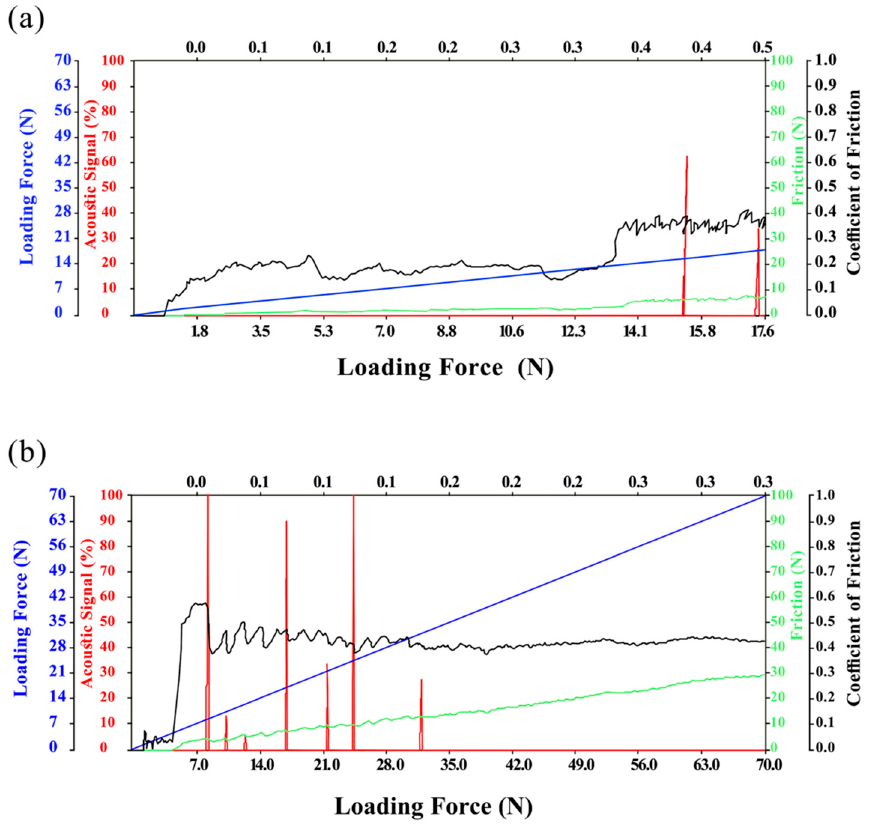
Figure 7. The scratch test of the coated archwires. The coating of NiTi specimen ( a ). The coating of SS specimen ( b ).